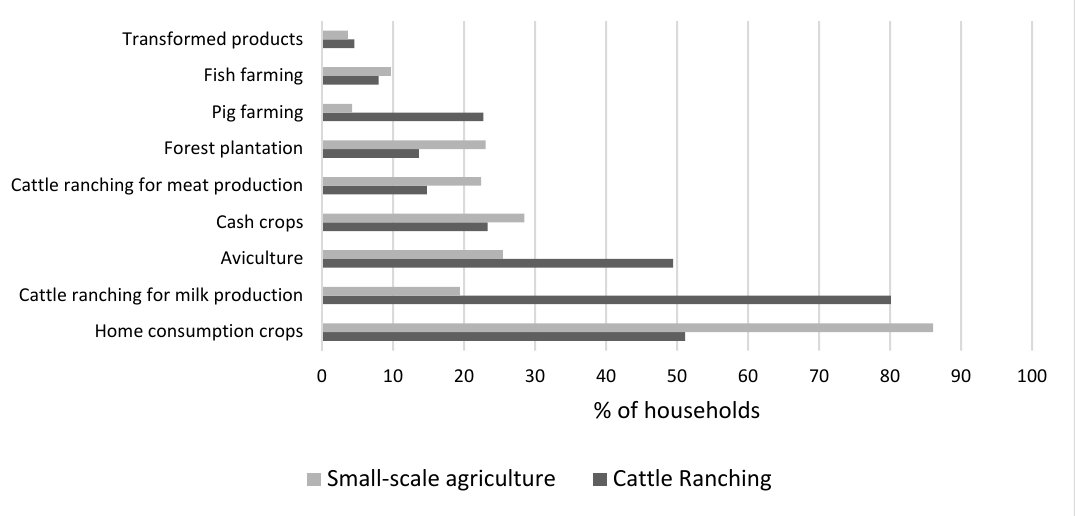
Figure 3. Productive activities reported on farms.